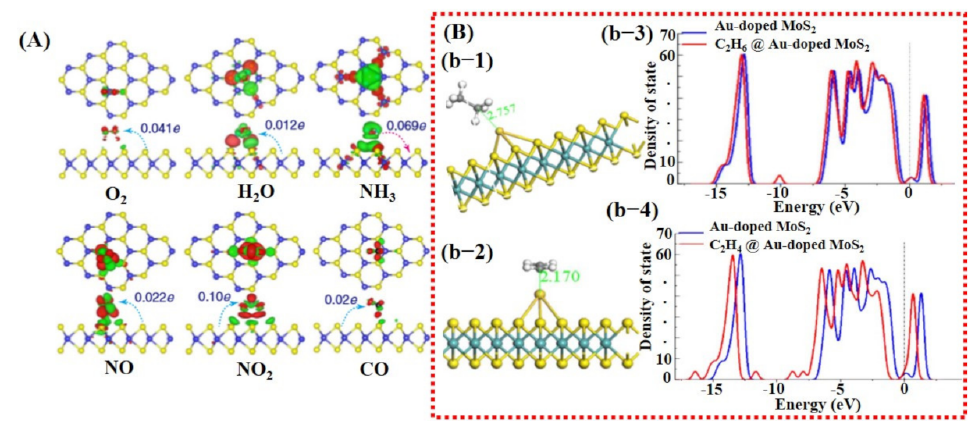
Figure 3. Computational analysis of MoS 2 and Au-doped MoS 2 for gas sensing using DFT calcula- tions: ( A ) The charge transfer between pure MoS 2 sheet and different target molecules; maximum charge transfer of 0.10 e can be seen for NO 2 , which is quite low, indicating the significance of heteroatom doping (reproduced with permission from [99], copyright 2013 Springer Nature). ( B ) The DFT results for Au-doped MoS 2 sheet: (b-1) a schematic illustration of C 2 H 4 and C 2 H 6 molecule on Au-doped MoS 2 with the corresponding bond length distance; (b-3,4) the DOS graphs for both the molecules before and after adsorption. A relatively larger change at Fermi energy level was found for C 2 H 4 , indicating better sensitivity of Au-doped MoS 2 towards C 2 H 4 . Reproduced with permission from [80], copyright 2020 Front. Mater.